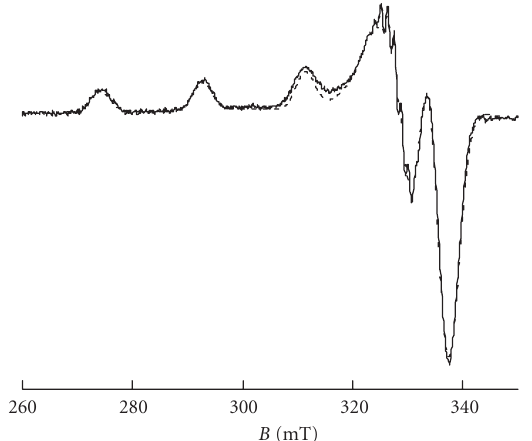
Figure 3: X band EPR spectrum of 1 in H 2 O/glycerol (10%), plain line: EPR spectrum, dotted line: simulation. EPR measurement con- ditions: temperature: 130 K, microwave frequency: 9.45 GHz, mi- crowave power 20 mW: modulation frequency: 100kHz, modula- tion amplitude: 2 G.